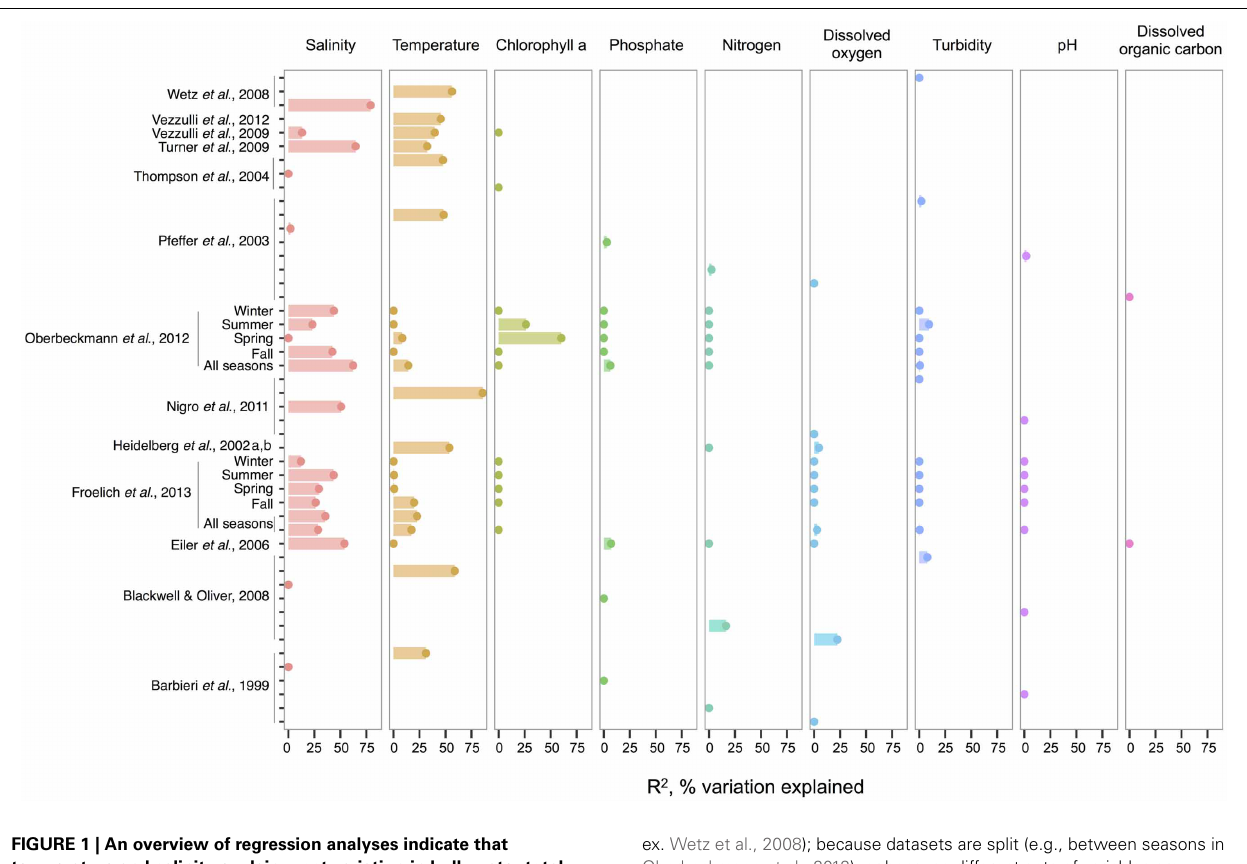
ex. Wetz et al., 2008); because datasets are split (e.g., between seasons in Oberbeckmann et al., 2012); or because different sets of variables are considered sequentially (e.g., two variables versus six variables in the two All Seasons models from Froelich et al., 2013). Dots indicate bar heights, and where a dot occurs without a bar, R 2 was non-significant (i.e., R 2 = 0). Variables may have been log or exponentially transformed in